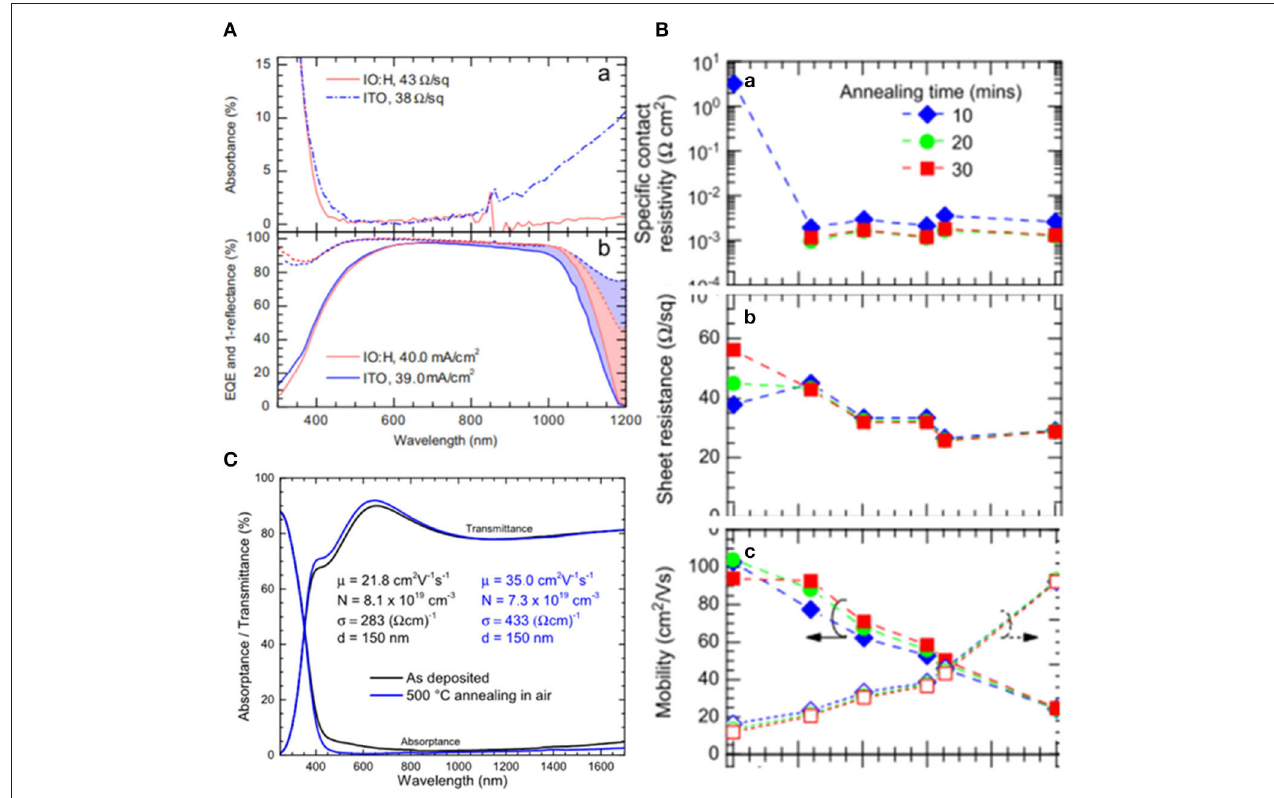
FIGURE 8 | (A) Absorbance spectra, external quantum efficiency (solid), and 1-reflectance (dashed) spectra of IO:H and ITO films on glass (reproduced from ref. 10, copyright 2013, Elsevier). (B) Specific contact resistivity, sheet resistance, and mobility and free electron density of IO:H/ITO bilayers on glass (reproduced from ref. 10, copyright 2013, Elsevier). (C) UV-vis-NIR spectrophotometric of a 150nm thick ZTO layer on glass before and after annealing at 50 ◦ C in air. Hall Effect characteristics are also given. l ¼ mobility; N ¼ carrier density; r ¼ conductivity; and d ¼ thickness (reproduced from ref. 73, copyright 2016,